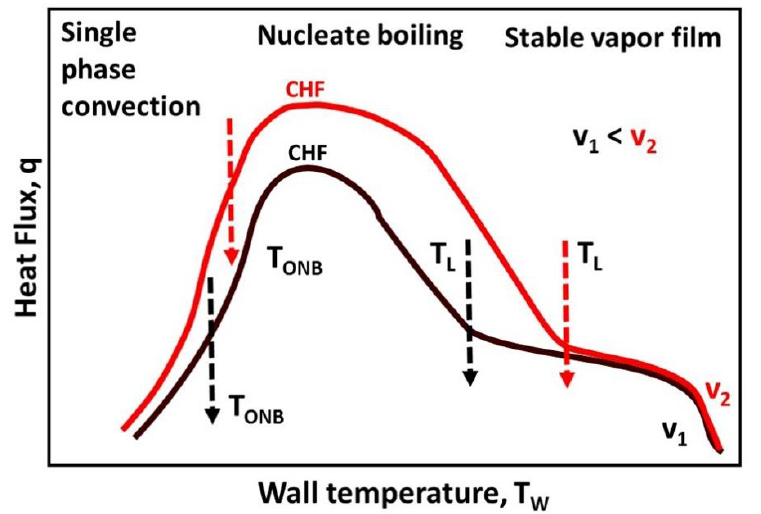
Figure 4. Schematic representation on the effect of liquid velocity on the boiling curve. Notice that Leidenfrost ( T L ) and onset of nucleate boiling ( T ONB ) temperatures change with fluid velocity, where velocity v 1 is smaller than velocity v 2 .